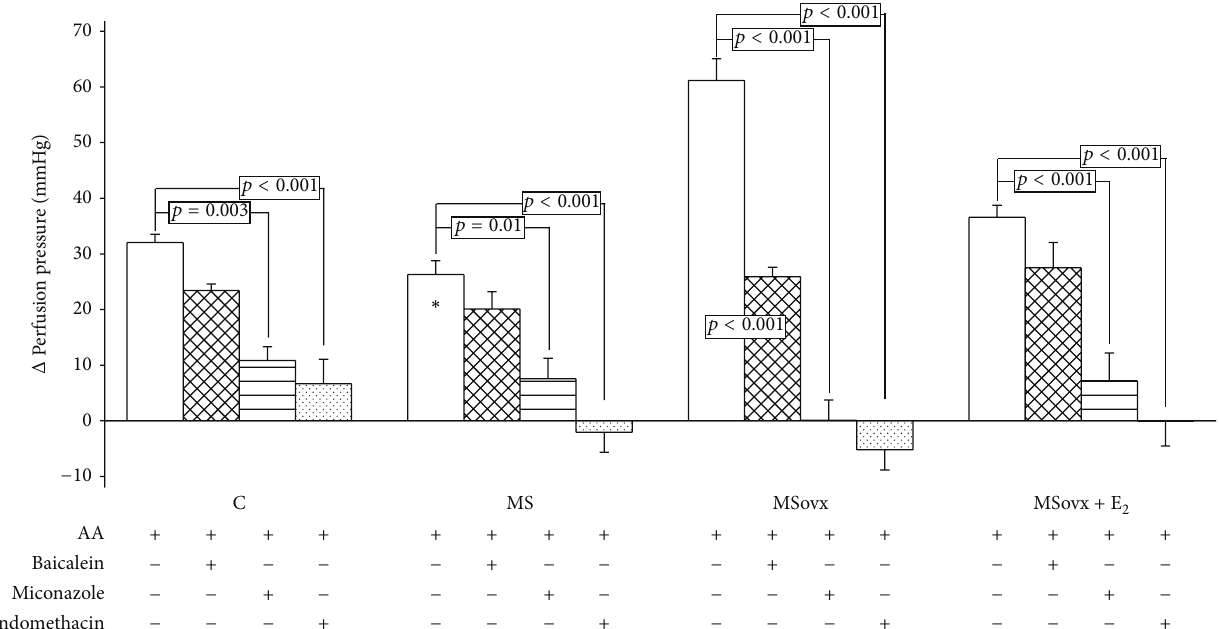
Figure 2: Arachidonic acid effect on Δ perfusion pressure in isolated kidney from experimental groups. Kidneys were perfused with 4 𝜇 g of AA in the absence or the presence of inhibitors. AA 4 𝜇 g, AA 4 𝜇 g plus 10 𝜇 mo/L Baicalein, AA 4 𝜇 g plus 5 𝜇 mol/L Miconazole, and 1 AA 4 𝜇 g